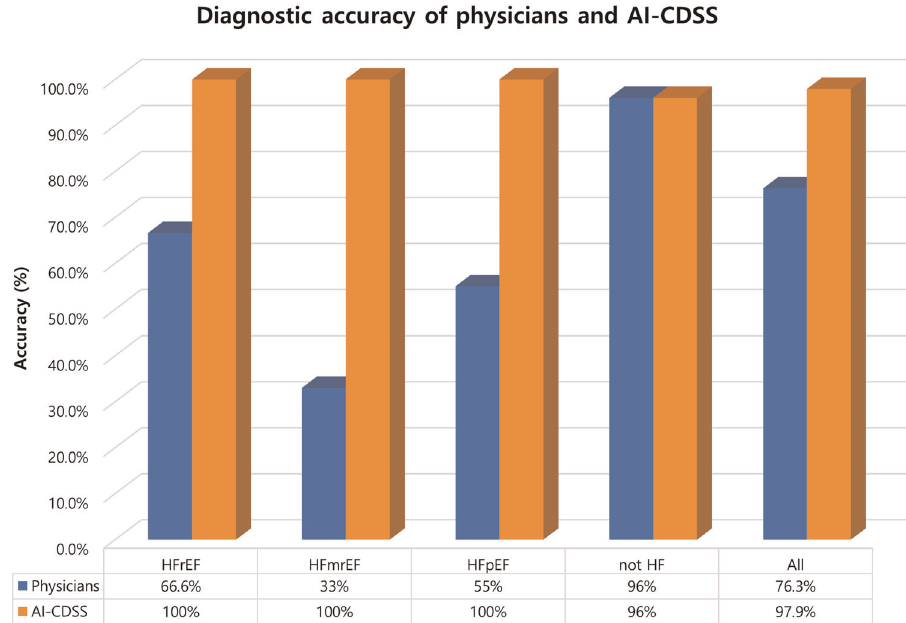
Fig. 3 Comparative analysis of the diagnostic accuracy of physicians and AI-CDSS in the prospective cohort. Abbreviations are as in Fig.